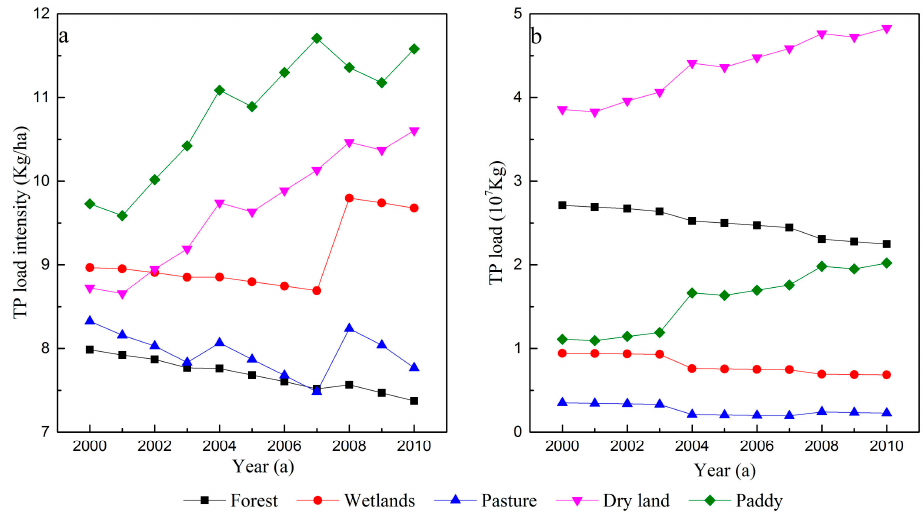
Figure 8. Load intensity ( a ); and load ( b ) of total phosphorus (TP) for each land use between 2000 and 2010.